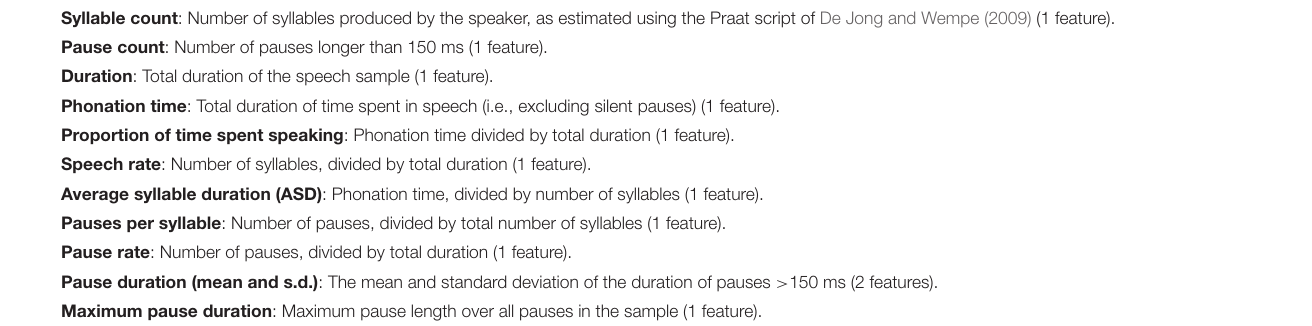
TABLE 3 | Speech features (12 features).